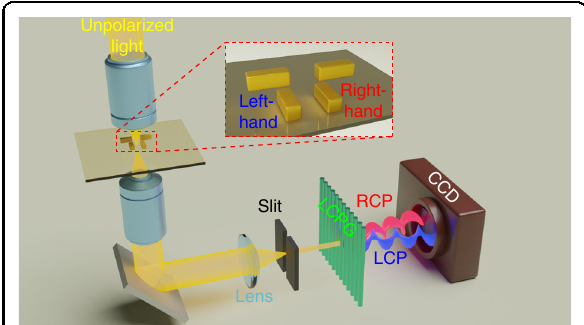
Fig. 1 Schematics of the polarization-dispersive spectrometer for Scattering Circular Dichroism Spectroscopy. CCD coupled charged detector, LCPG liquid crystal polarization